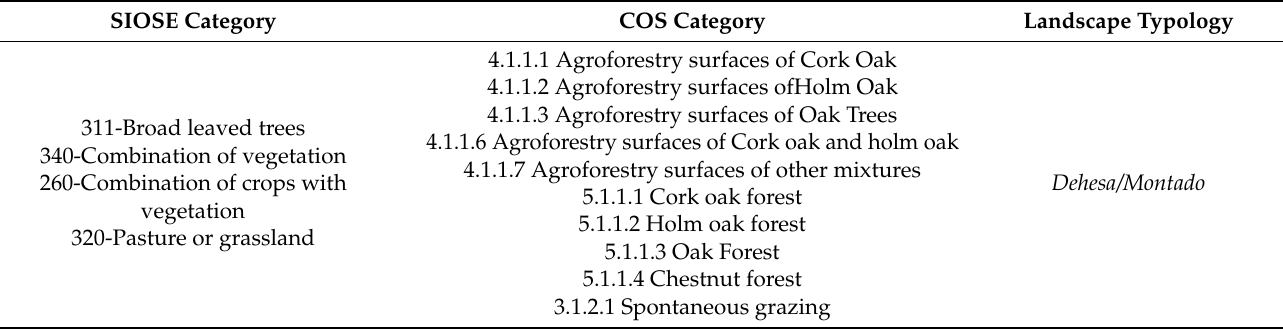
Table 1. Land use categories SIOSE, obtained from the Land use/cover maps of Portugal and Spain. SIOSE Category Landscape